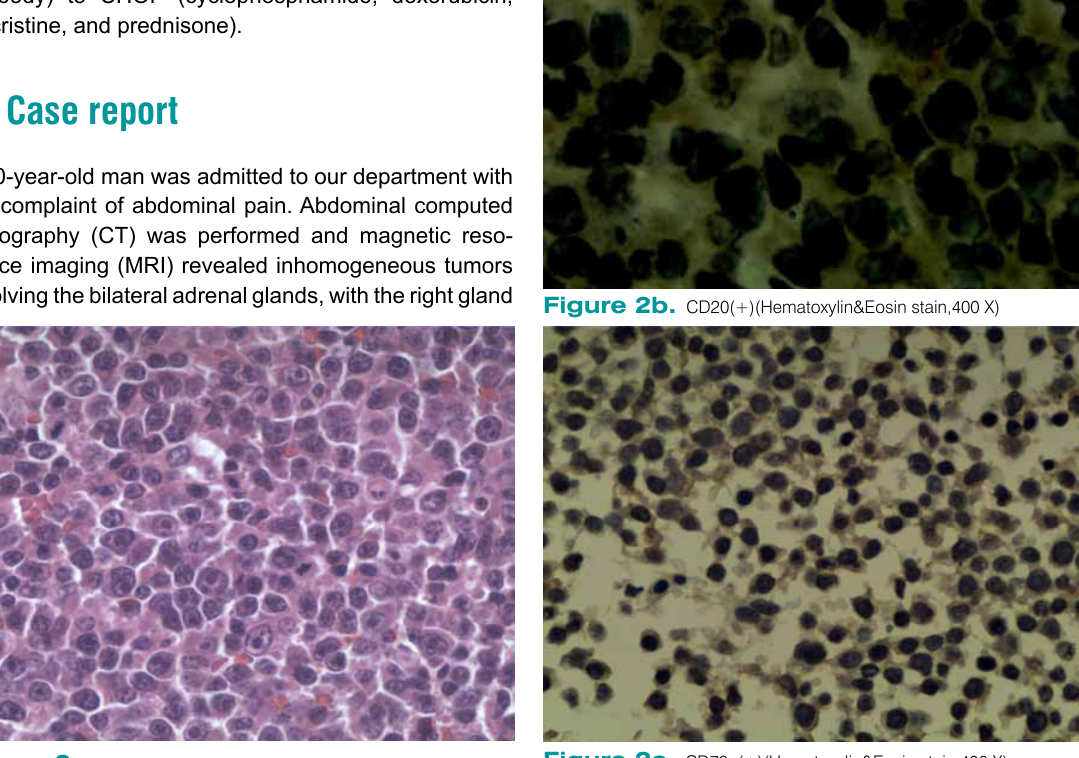
Figure 2c. CD79a(+)(Hematoxylin&Eosin stain,400 Figure 2a. Diffuse large B-cell non-Hodgkin’s lymphoma (Hematoxylin&Eosin stain, 400 X). Figure 2. Diffuse large B-cell non-Hodgkin’s lymphoma was diagnosed according to histopathological examination (Figure 2a). Immunohistochemical staining demonstrated that most tumor cells were positive for CD20 (Figure 2b) and CD79a (Figure 2c).